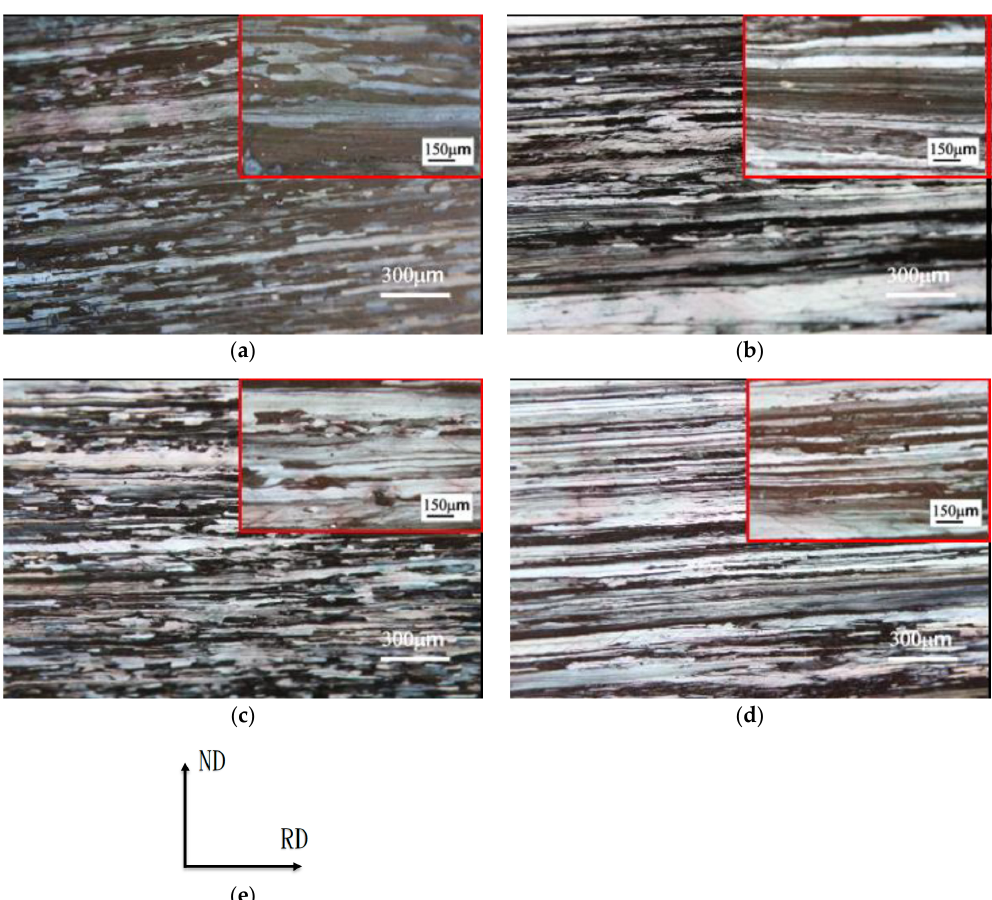
Figure 4. Cross-sectional microstructures of as-cold-rolled specimens observed by optical microscope (OM); ( a ) 1-Hom. alloy A(0.1Zr); ( b ) 1-Hom. alloy B(0.05Sc); ( c ) 2-Hom. alloy A(0.1Zr); ( d ) 2-Hom. alloy B(0.05Sc); ( e ) cross-sectional direction. ND, normal direction; RD, rolling direction.